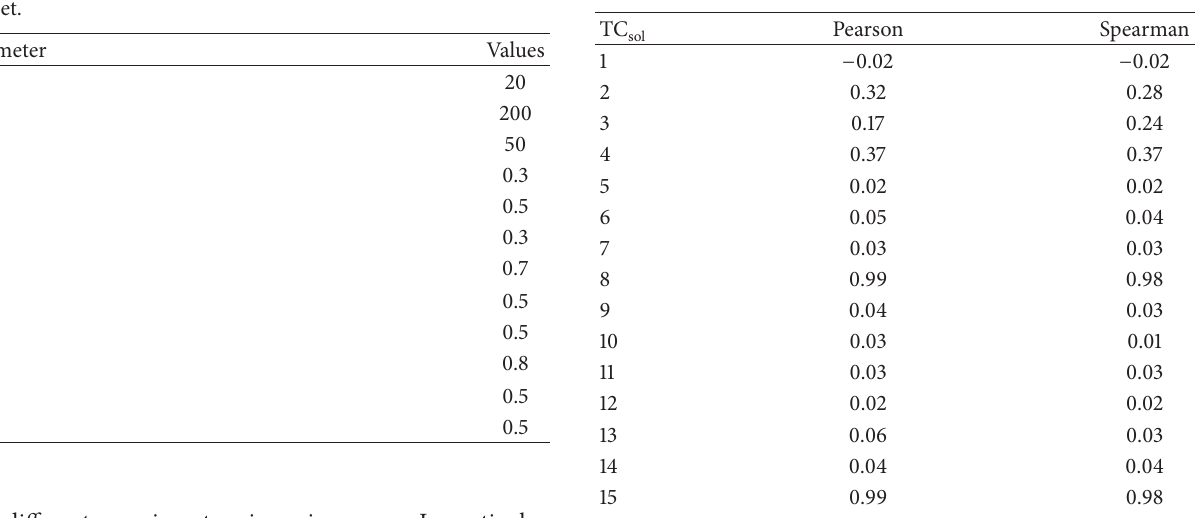
Table 4: Correlation results for tricluster Yeast Cell Cycle Dataset.